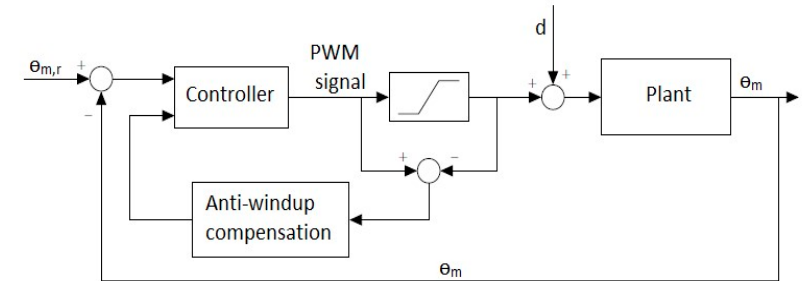
Figure 7. Control scheme to control a motor.